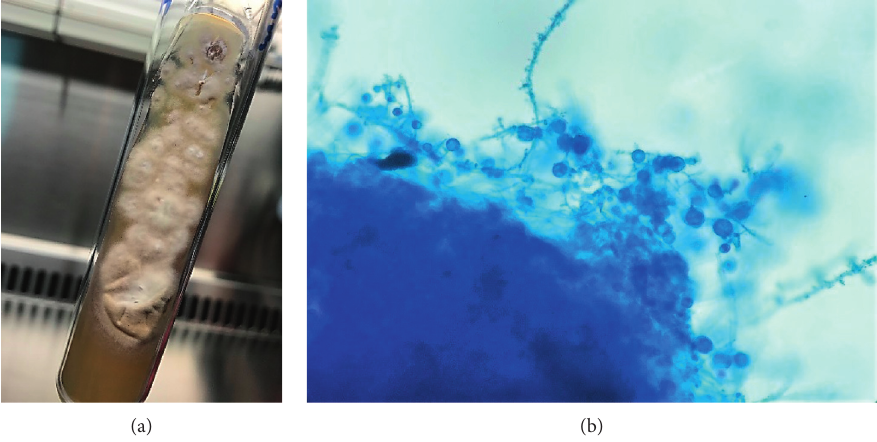
Figure 2: (a) The colonies of mold form. (b) Lactophenol cotton blue stain showing hyphae with numerous tuberculate